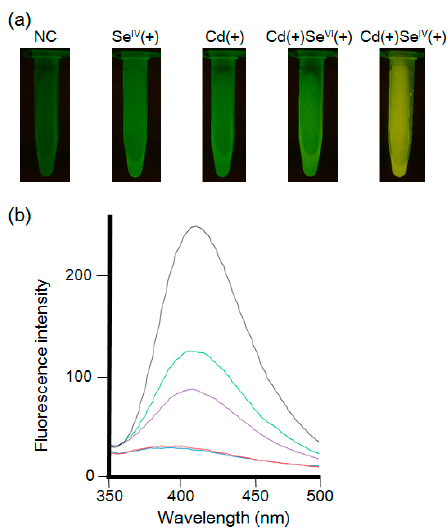
Figure 2. ( a ) F. oxysporum after the treatment of cadmium and/or selenium solution observed under the ultra violet (UV) light (wavelength: 365 nm). NC: Negative control without treatment of cadmium and selenium solution. Se IV (+): 5 mM Na 2 SeO 3 treatment. Cd (+): 5 mM CdCl 2 treatment. Cd (+) Se VI (+): 5 mM CdCl 2 and 5 mM Na 2 SeO 4 treatment. Cd (+) Se IV (+): 5 mM CdCl 2 and 5 mM Na 2 SeO 3 treatment; ( b ) The fluorescence spectra (excitation at 310 nm) of extracts from the mycelial cells in each condition using ultrasonication. Bold black line: 5 mM Cd (+) Se IV (+). Green line: Cd (+). Purple line: Cd (+) Se VI (+). Red line: Se IV (+). Blue line: negative control.